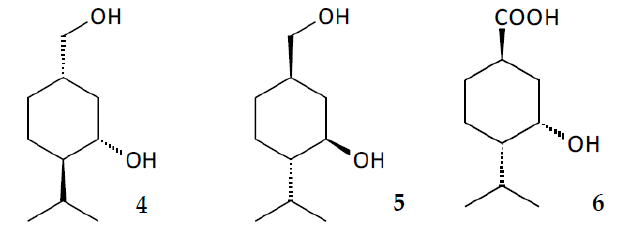
Figure 12. Structures 4 , 5 and 6 .